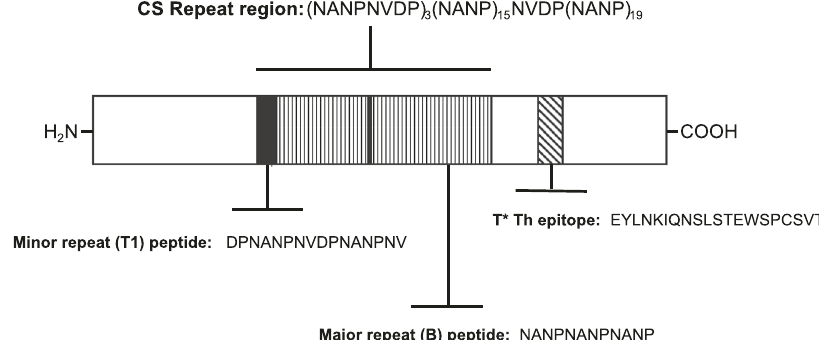
Fig. 1 Schematic of the P. falciparum CS proteins and peptides. Illustration of P. falciparum CS protein showing the B major (NANP) tetramer repeats (open bars) and the T1 minor repeat epitope comprised of alternating NVDP NANP repeats (solid bars). Synthetic tetrabranched peptides representing the major repeats NANPNANPNANP, or minor repeats DPNANPNVDPNANPNV, were used as antigens in the ELISA to measure fi ne speci fi city of polyclonal and monoclonal antirepeat antibody responses. The T* epitope (hatched bar) is a universal T helper cell epitope located in the C -terminus (aa 326 – 345 NF54 isolate) that is recognized by a broad range of human and murine class II HLA genotypes. Peptide immunogens were constructed as either linear or tetrabranched peptides comprised of major repeats combined with the T* universal T helper cell epitope, (NANP) 3 EYLNKIQNSLSTEWSPCSVT (designated BT*), or minor repeats combined with T* universal T helper cell epitope